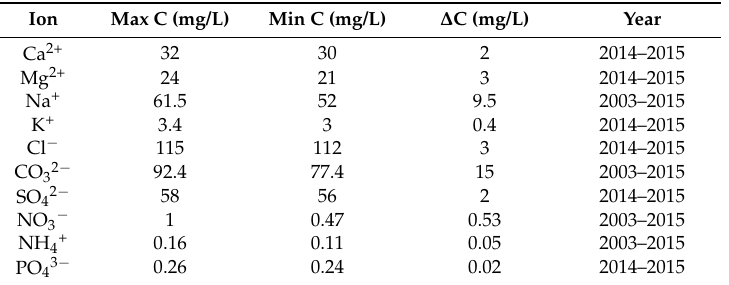
Table 2. Major ion concentration of Ann Arbor tap water.